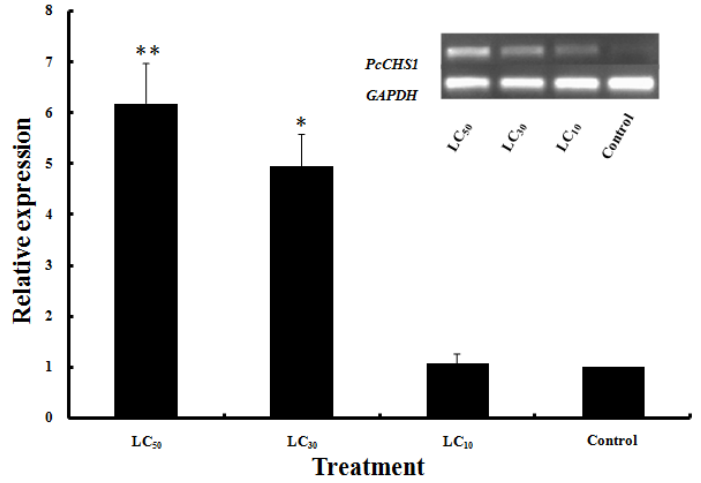
Figure 5. Effects of diflubenzuron (DFB) treatment on the expression pattern of the chitin synthase 1 gene, PcCHS1 from the citrus red mite, Panonychus citri (Acari: Tetranychidae). Relative expression of the PcCHS1 of P. citri exposed to 0.17, 1.31 and 5.32 mg/L DFB (LC , LC and LC ) in 0.1% Triton-100 at the larval stage for 6 h using a 10 30 50 leaf-dip bioassay were analyzed using qPCR ( n = 3). Water, containing 0.1% Triton-100, treated P. citri were used as the controls. The error bars were generated after examining the relative level of PcCHS1 in P. citri . An asterisk (*) on the error bar indicates a significant difference between DFB treatment and control; * ( p < 0.05) or ** ( p < 0.01, t -test). GAPDH was used as a reference